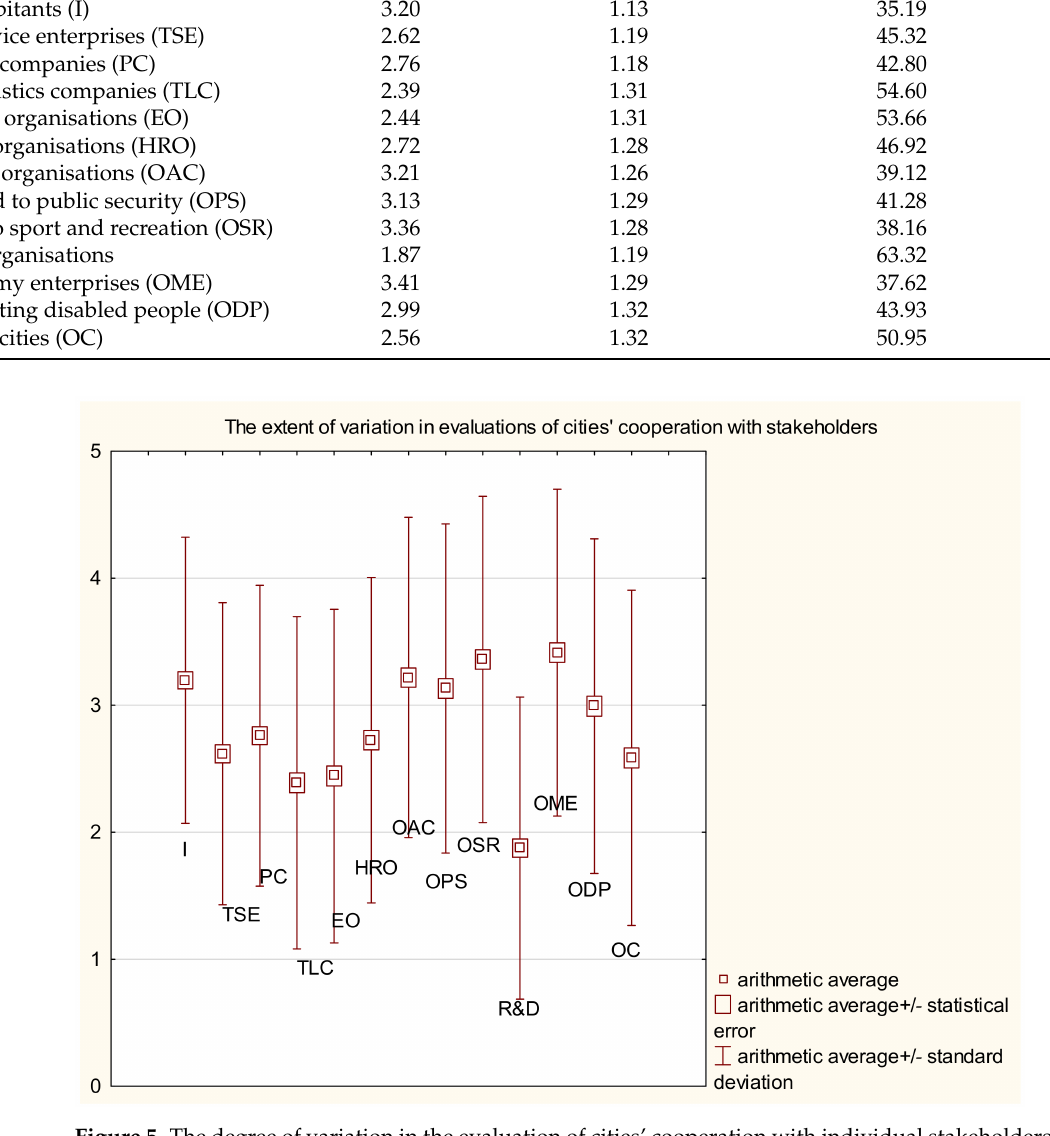
Figure 5. The degree of variation in the evaluation of cities’ cooperation with individual